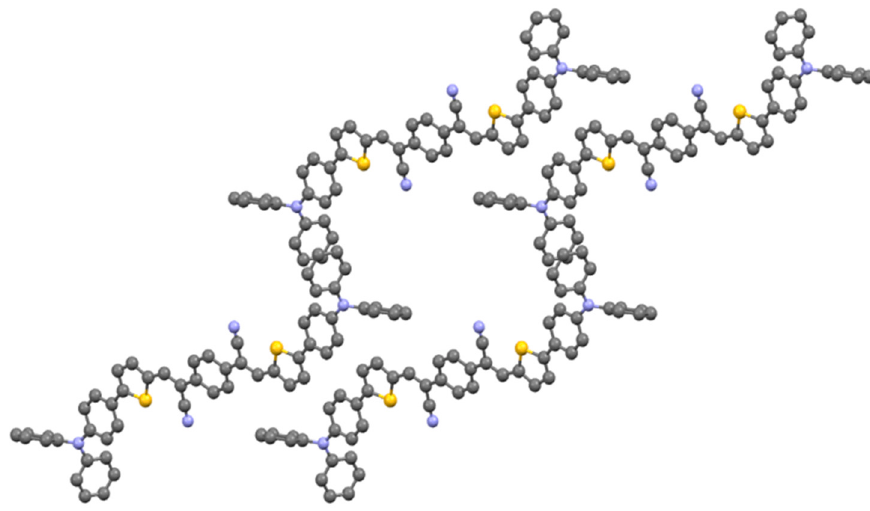
Figure 3. Packing of AS2 along the c axis.